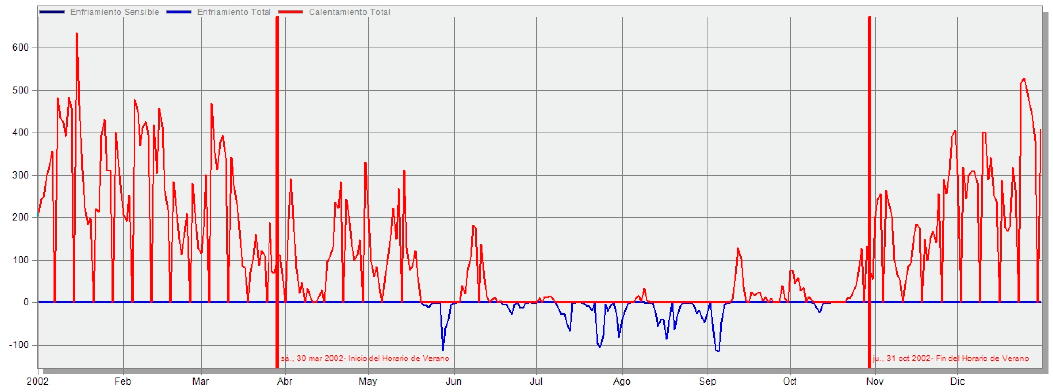
Figure 6. Heating demand in kilowatts calculated over a year.